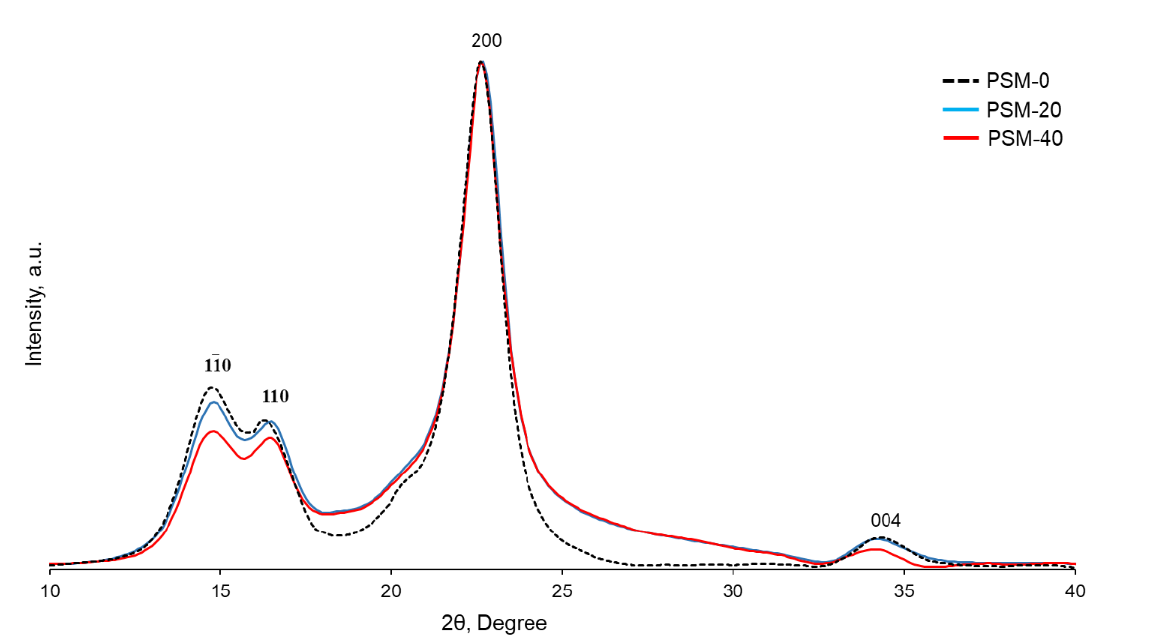
Figure 8. XRD patterns of control and oxygen plasma surface modified (PSM-20 and PSM-40) cotton fibers.